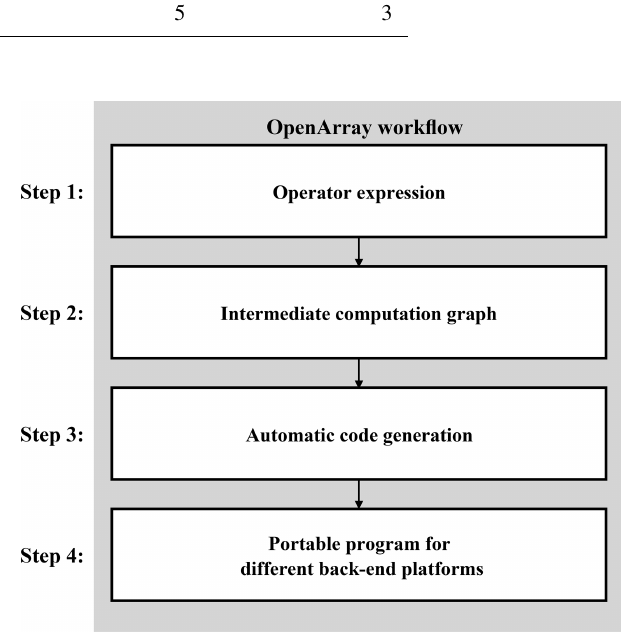
Figure 5. The workflow of